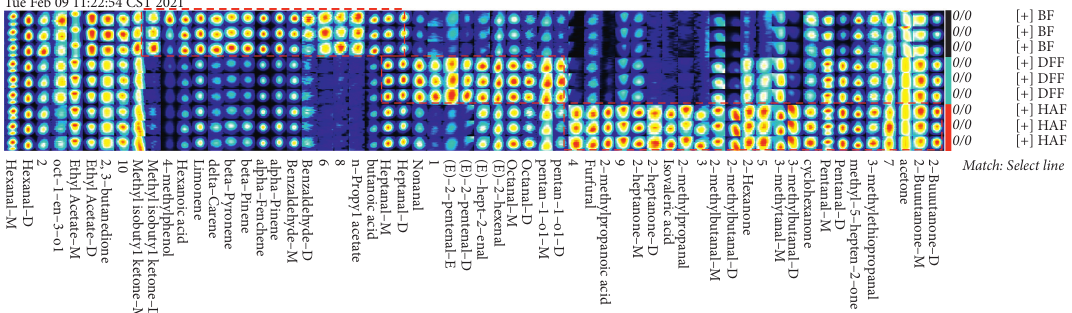
Figure 4: Fingerprint of volatile organic compounds of giant salamander meatball before and after frying.